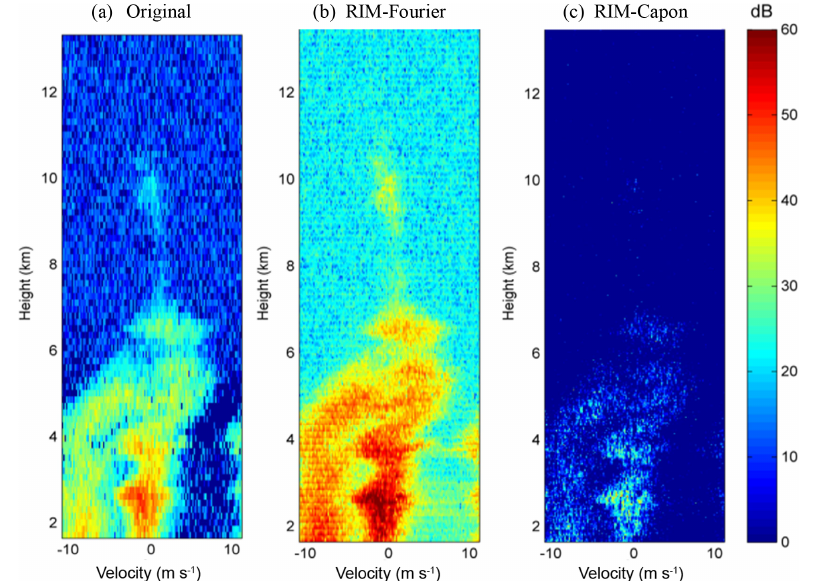
Figure 1. (a) Power spectra at the original resolution of 150m. Data time and date: 19:17:20UT, 21 August 2013. Panels (b, c) are Fourier RIM and Capon RIM power spectra, respectively. A constant range delay and range-weighting function corrections have been made in range imaging. Imaging step is